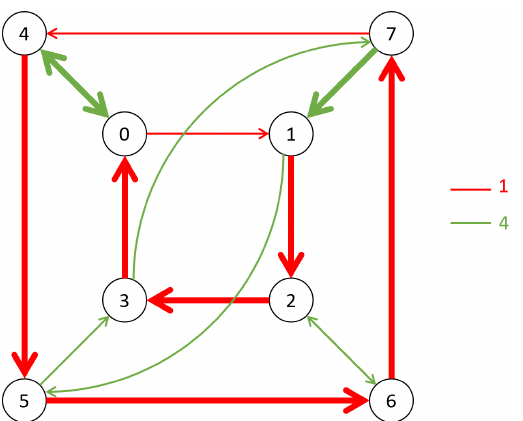
Figure 5. The right-Cayley graph R-Cay ( G ( 3 ) , { 1,4 } ) with the Hamiltonian cycle 0 [ 4 [ 1 ] 3 ] 2 shown in thick